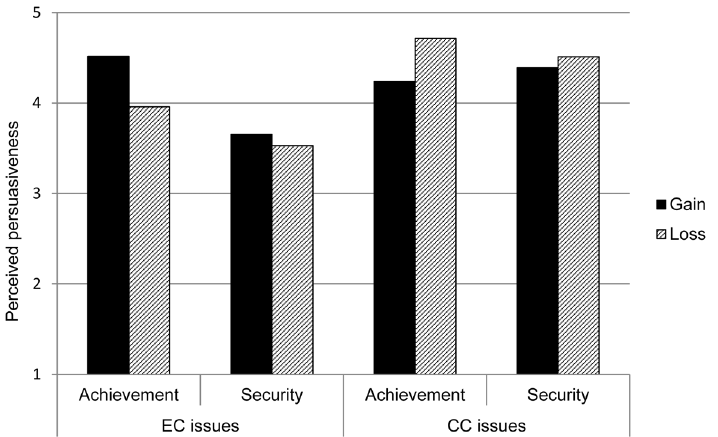
Figure 1. Perceived persuasiveness as a function of type of issue, outcome focus and type of benefit (Study 1).